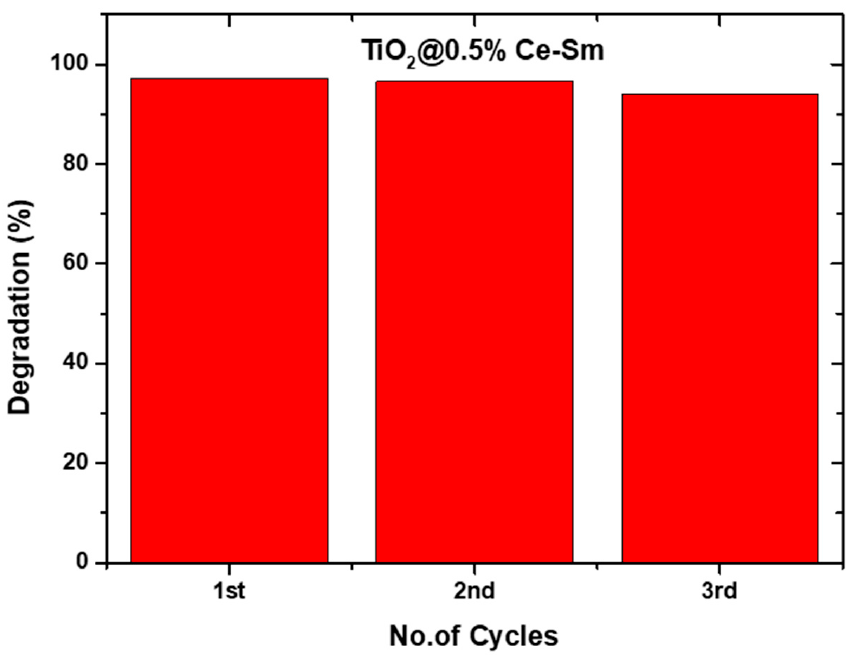
15 of 23 Figure 12. Kinetics simulation curve of Ce–Sm co-doped TiO 2 NPs ( x = 0.00, 0.25, 0.50, 1.00, and 2.00%). The reusability and stability of the Ce–Sm co-doped TiO 2 NPs are among the im- portant factors of nano-photocatalysts for the degradation of dyes. Accordingly, Ce–Sm co-doped TiO 2 NPs with x = 0.50% were subjected to consecutive photocatalytic experi- ments against RB dye under the same starting conditions to verify their stability (Figure 13). After each experiment, centrifugation was used to recover the nanoparticles, which will be then dried in the oven and ground again using agate mortar. These experiments